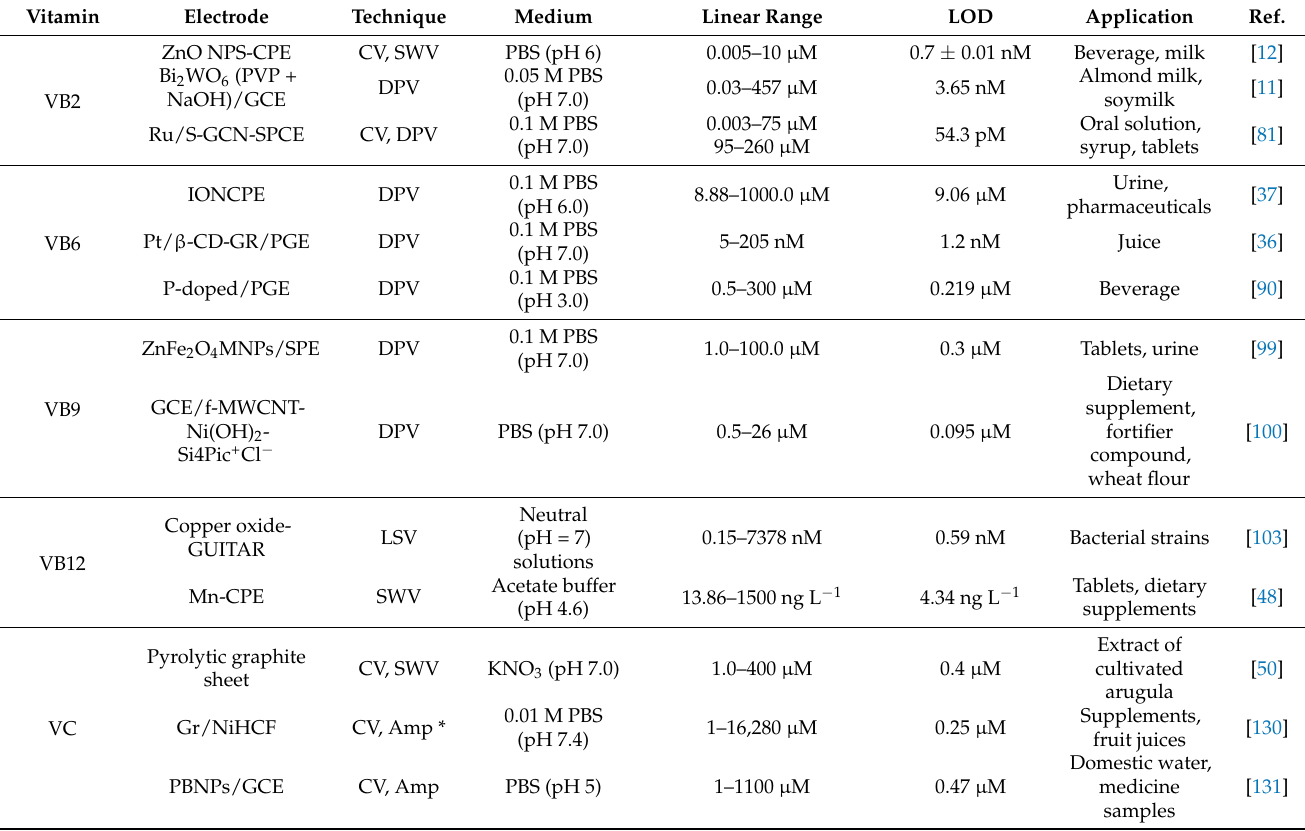
Table 2. A summary of electrochemical vitamin